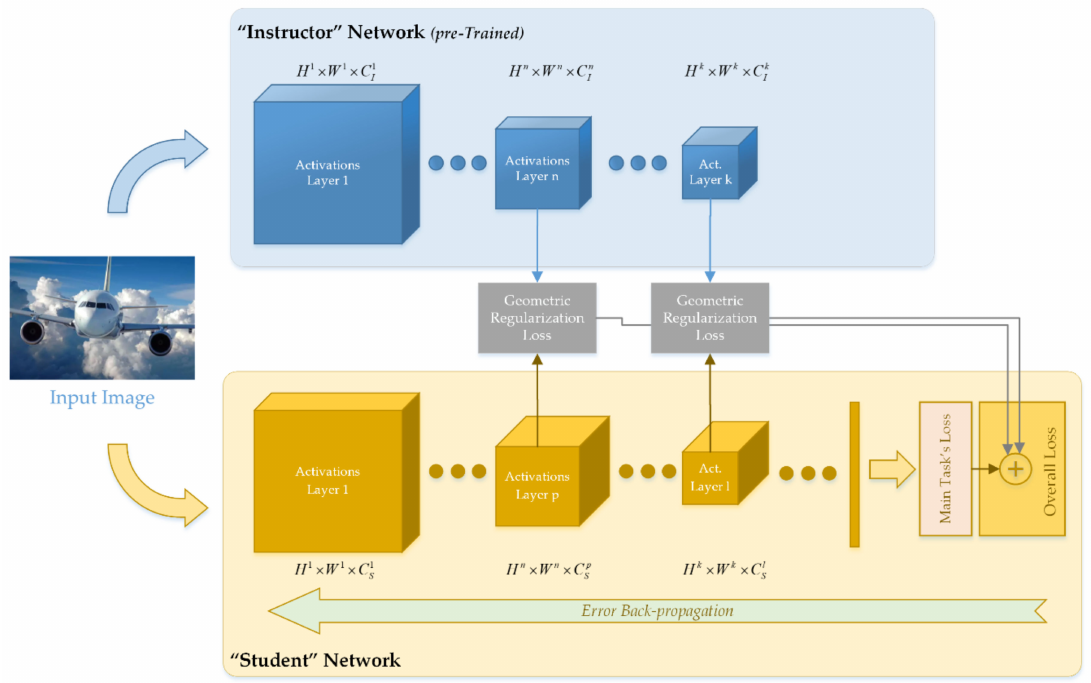
Figure 1. Overview of the proposed scheme for geometric regularization of local activation